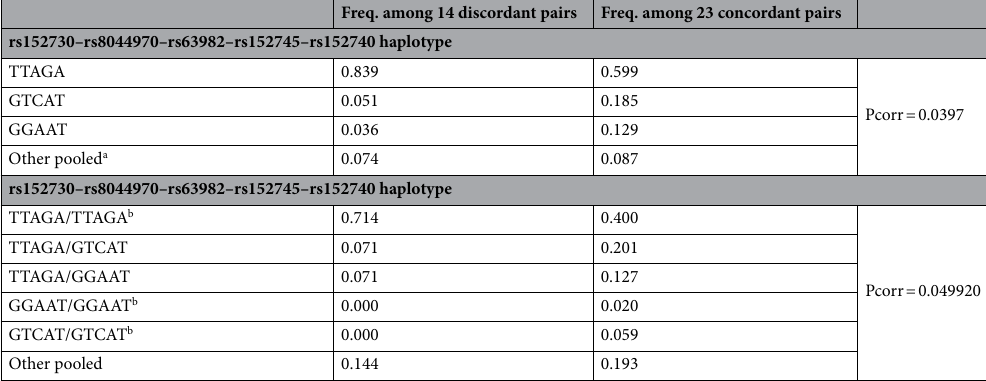
Table 1. Haplotype and diplotype distribution observed among concordant and discordant cystic fibrosis F508del homozygous sibling pairs for markers rs152730, rs8044970, rs63982, rs152745, rs152740. a Four rare haplotypes (Freq. < 0.05) were observed among discordant pairs, 8 rare haplotypes (Freq. < 0.05) were observed among concordant pairs. b To identify all genetic variants associated with intrapair discordance on the genomic fragment rs12730–rs152740, the entire 8000 bp genomic fragment was compared by Sanger re-sequencing for three homozygotes for TTAGA, two homozygotes for GGAAT and one homozygote for GTCAT (see Table 2).